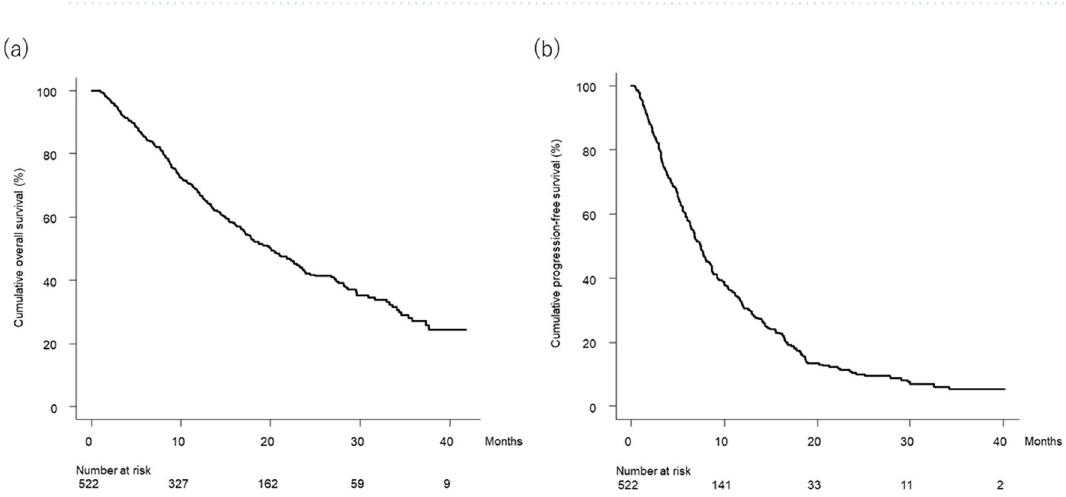
Figure 1. ( a ) Cumulative overall survival curve. Cumulative overall survival at 6, 12, 18, 24, 30, and 36 months was 85.4%, 67.6%, 52.7%, 42.2%, 35.2%, and 27.1%, respectively. ( b ) Cumulative progression-free survival curve. Cumulative progression-free survival at 3, 6, 9, 12, 15, and 18 months was 80.2%, 59.1%, 41.3%, 31.4%, 24.1%, and 17.4%,